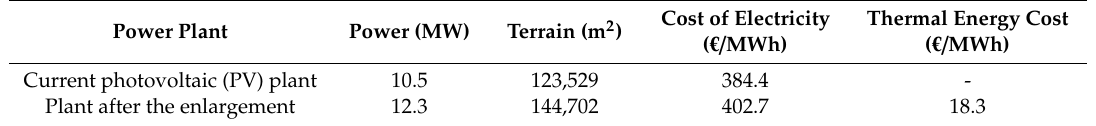
Table 3. Electricity and thermal energy cost data.